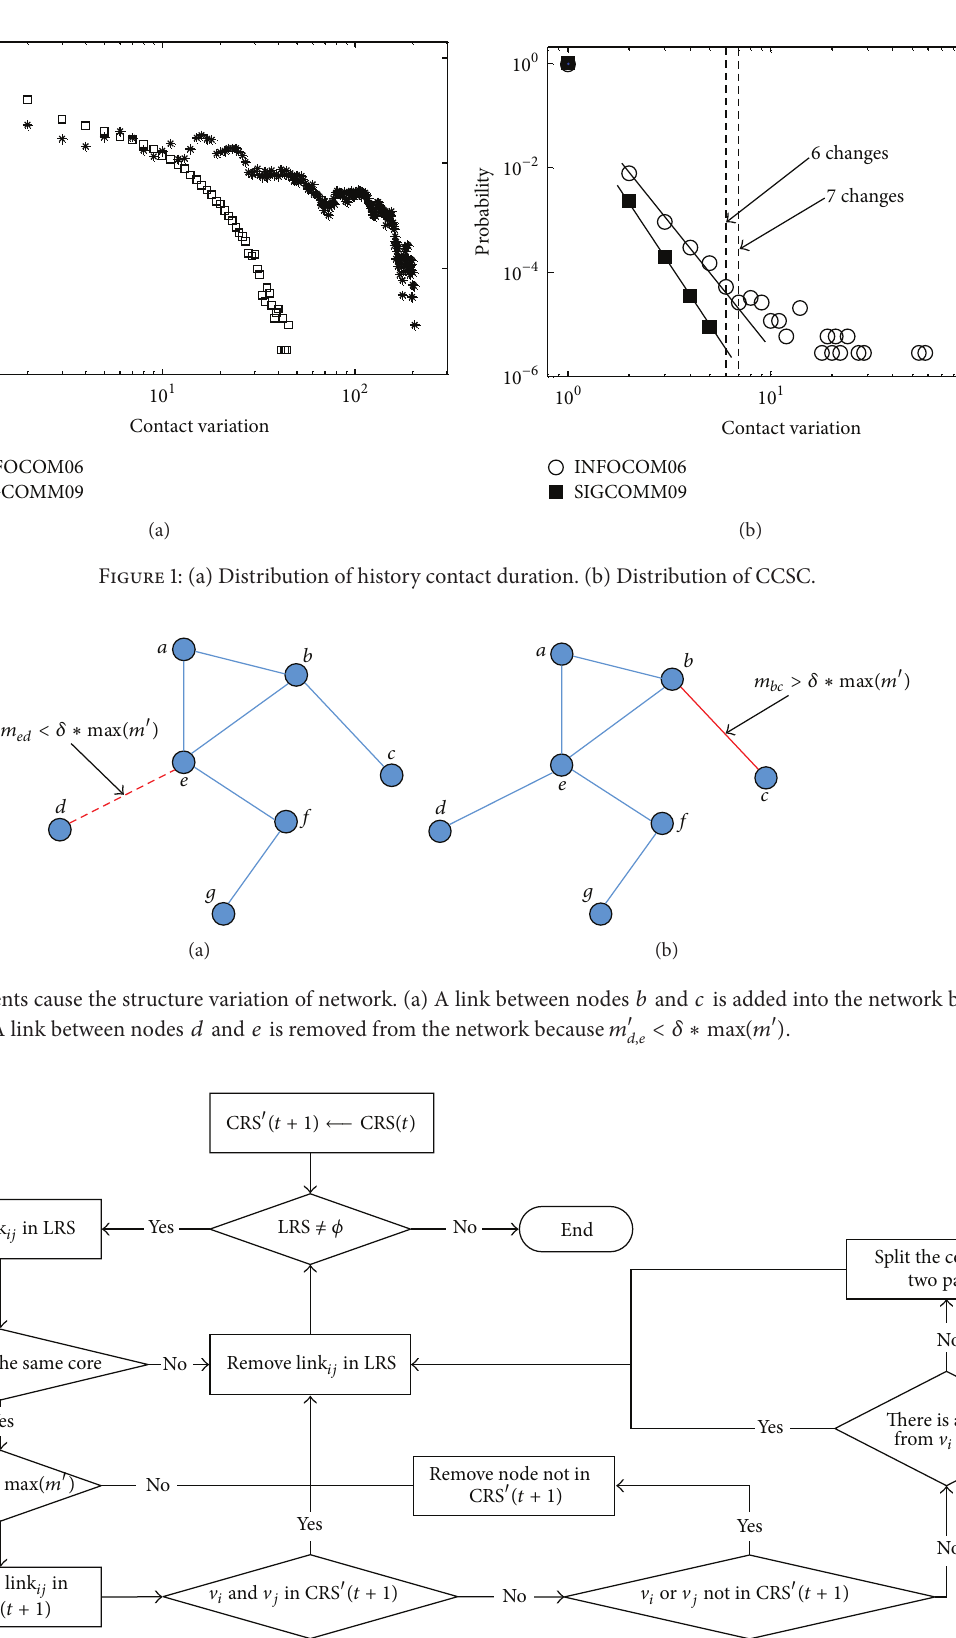
Figure 3: Basic operation procedure of link